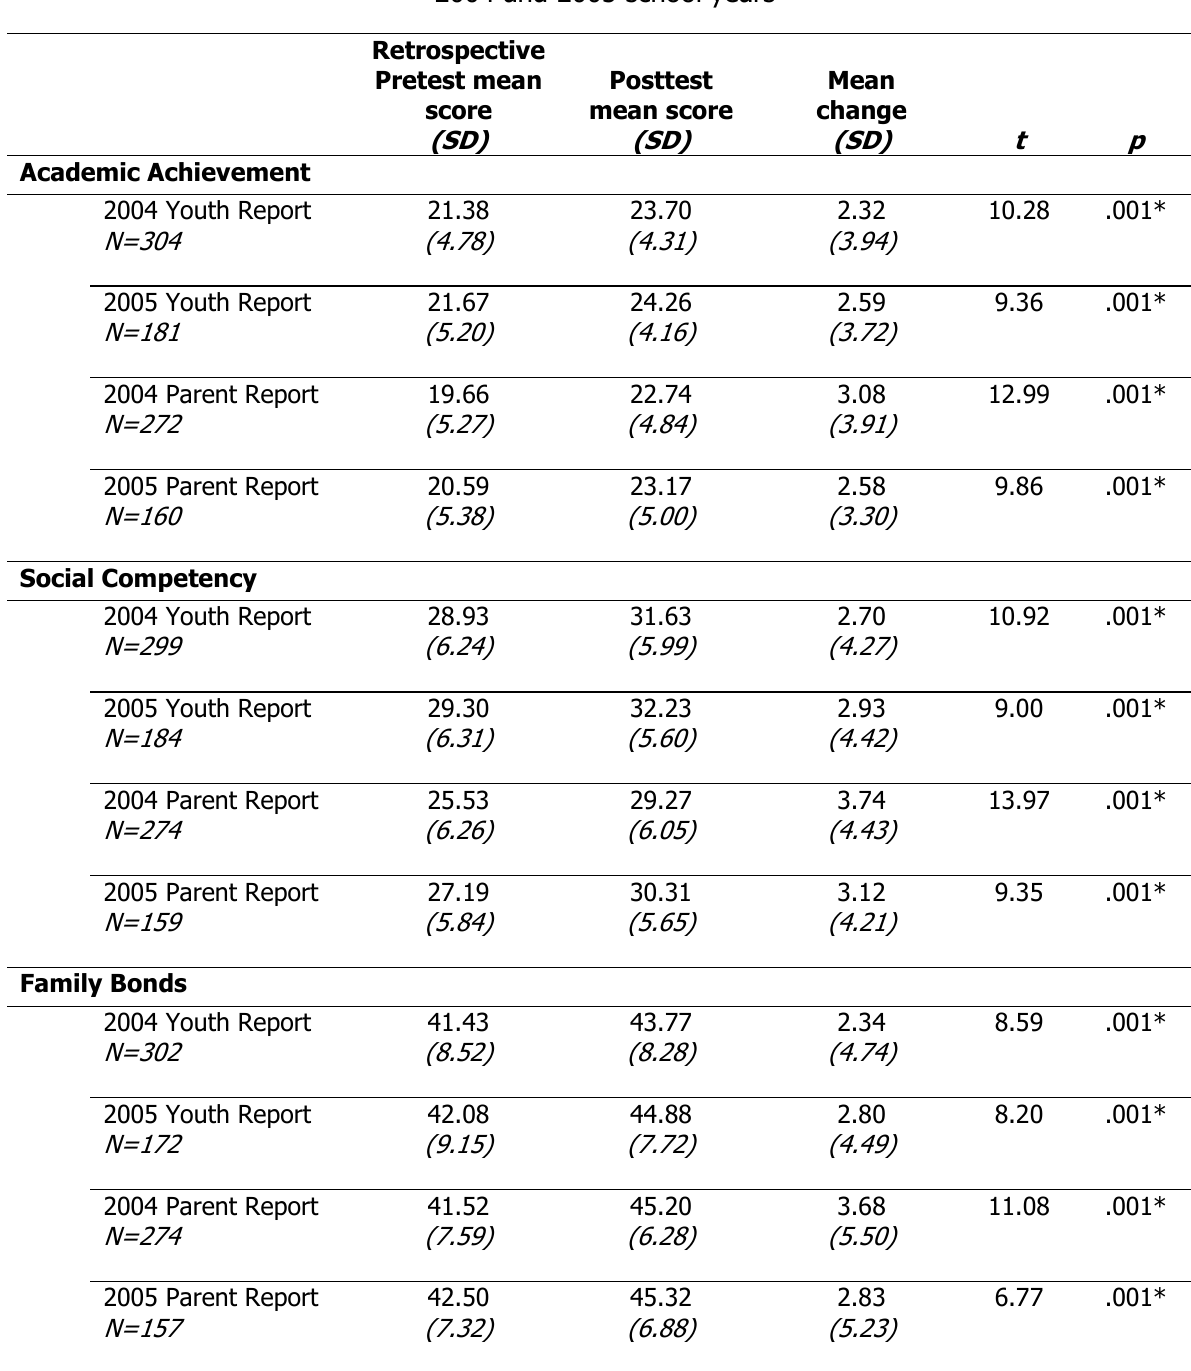
Paired samples t -test results of youth and/or parents’ perceptions of youth academic achievement, social competency, and family bonds for